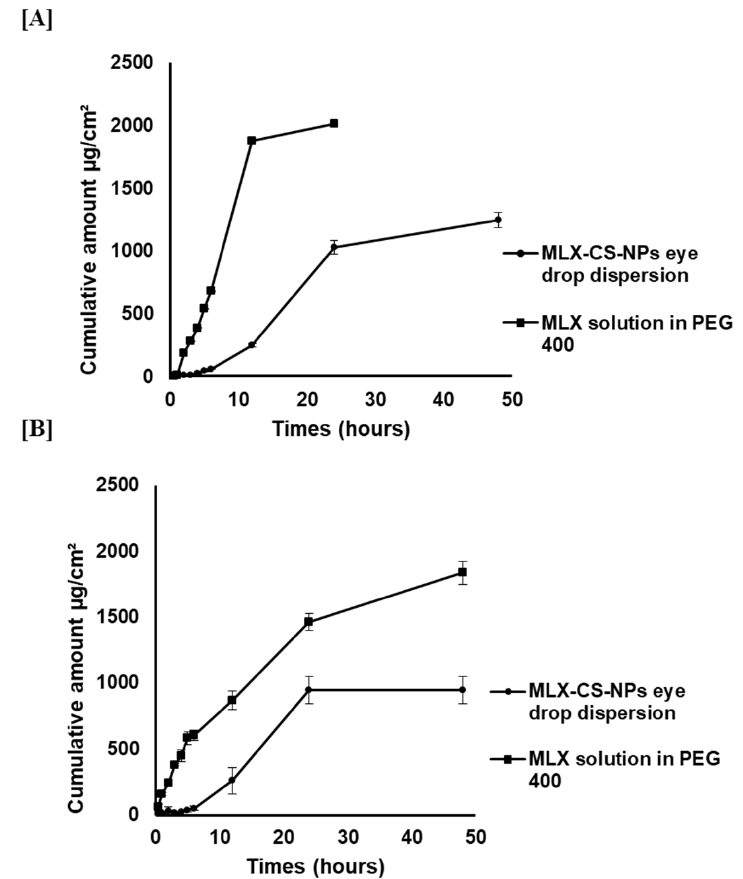
Figure 4. Ex vivo permeation of MLX from MLX-CS-NPs dispersion and MLX solution in PEG 400 ( A ) trans-corneal permeation and ( B ) trans-scleral permeation, data are presented as the mean ± SD ( n = 3). Abbreviations: MLX-CS-NPs; MLX/chitosan nanoparticles. Table 8. Permeation parameters of MLX through cornea and sclera of rabbit eye from MLX-CS-NPs dispersion and MLX solution in PEG 400.